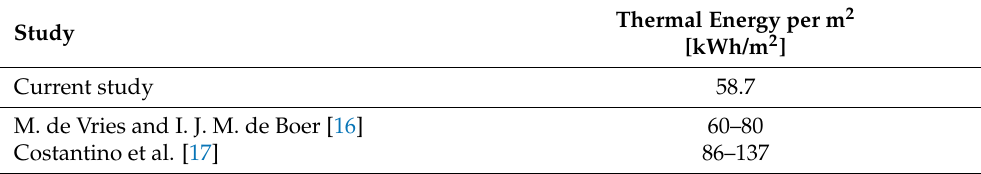
Table 7. Comparison of simulated thermal energy use for heating with literature